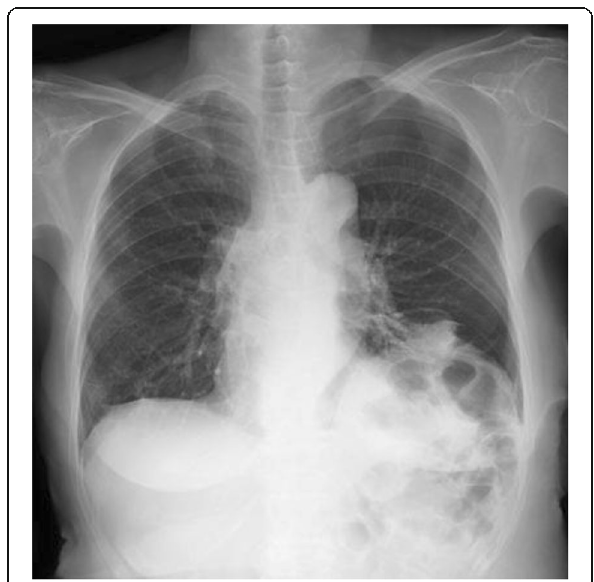
Fig. 4 Chest X-ray after diaphragm plication. The improvement in the left lung expansion after plication